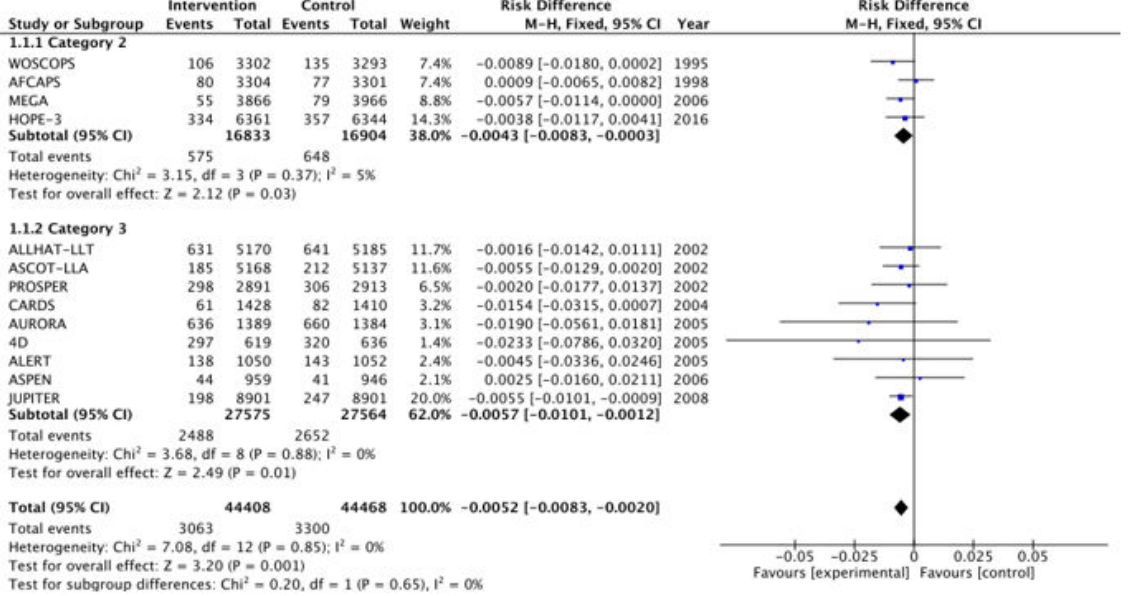
Figure 3. Risk difference across Category 2 and 3 studies for the primary outcome of all-cause mortality. Heterogeneity across studies was low, so fixed effects were used for the meta-analysis (Heterogeneity: Chi 2 = 7.08, p = 0.85, I 2 =